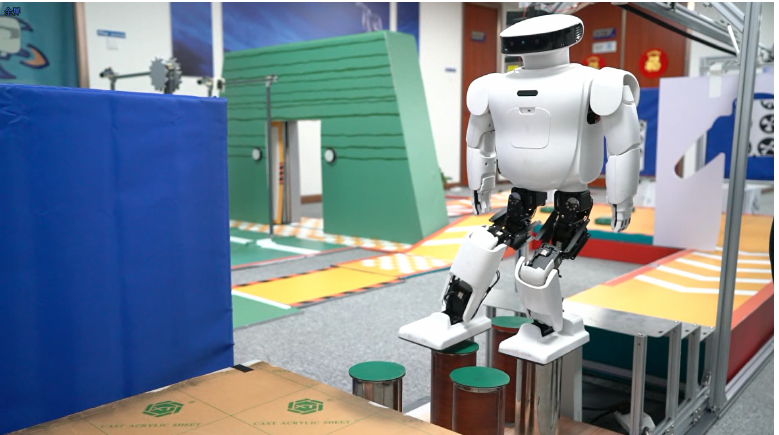
Figure 11. Discrete terrain walking. The walking area is limited to two rows of support